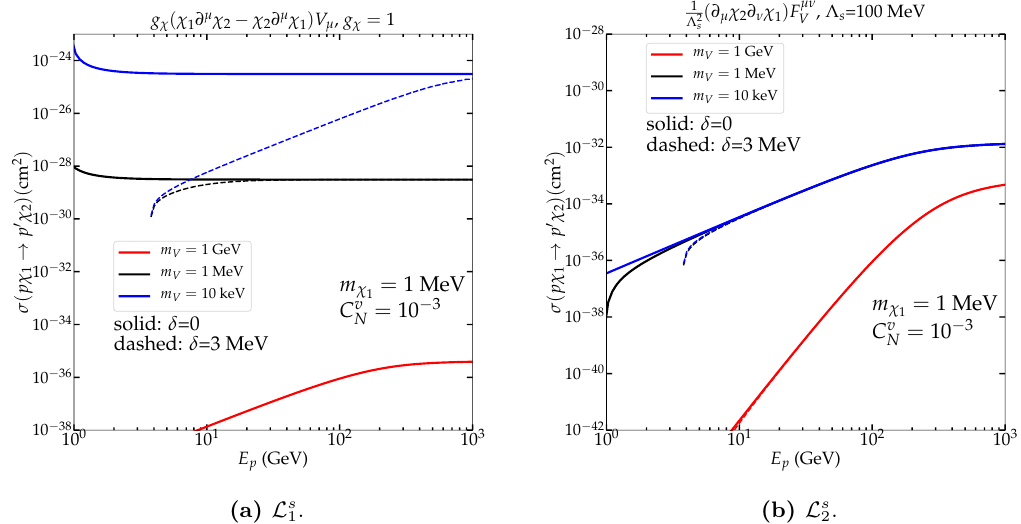
Figure 5. Same as in figure 3 but for scalar DM scenario. The left and right panels are for the interactions L s and L s , 1 2